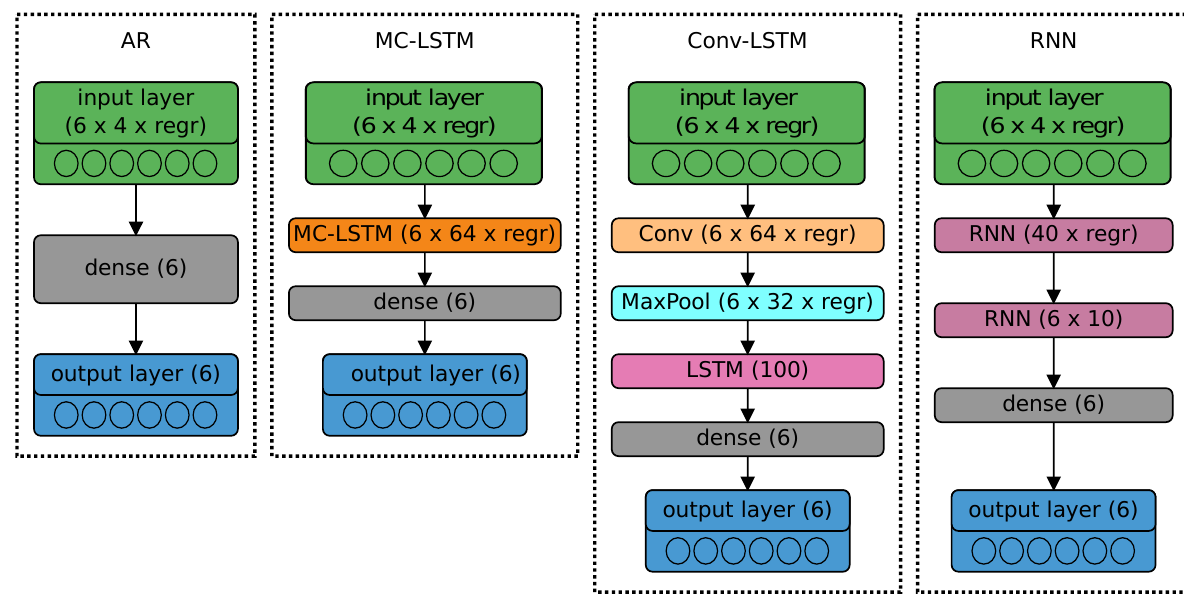
Figure 3. Structures of tested models predicting motor current (ˆ I ) on the output layer (6 neuron nodes), with a linear activation